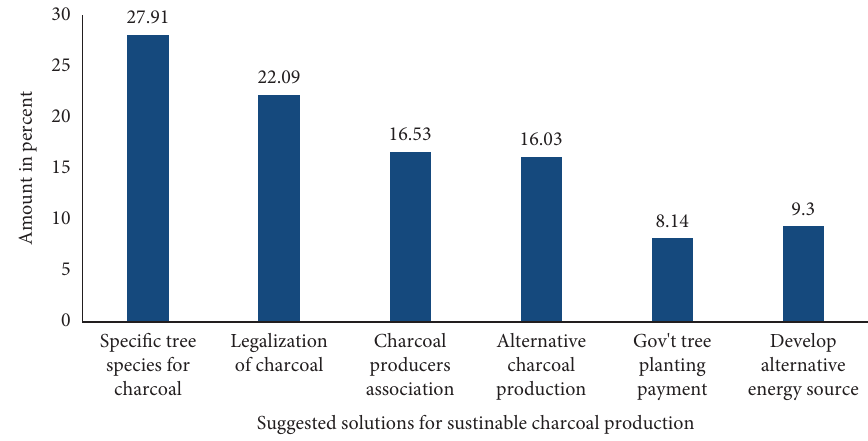
Figure 7: Suggestion for sustainable charcoal production. source: survey result